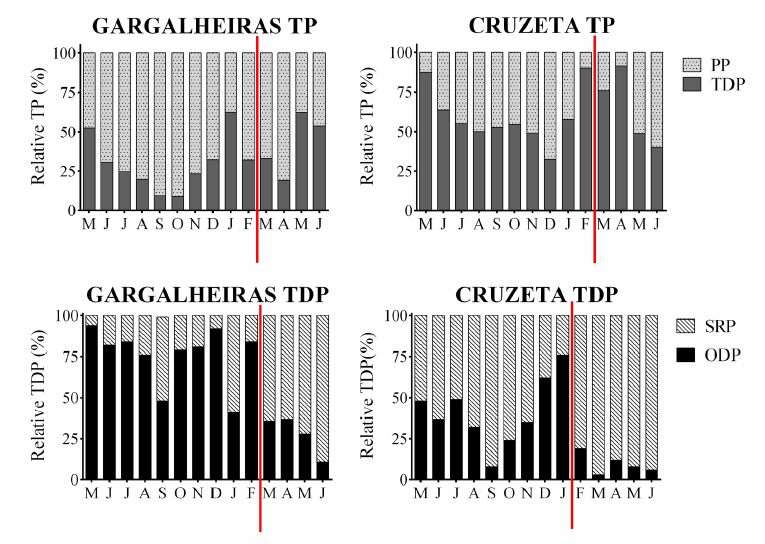
Figure 7. Relative Total phosphorus (TP) for Gargalheiras and Cruzeta, composed of the fractions of Particulate Phosphorus (PP) and Total Dissolved Phosphorus (TDP); and Relative Total Dissolved Phosphorus (TDP), composed of the fractions of Soluble Reactive Phosphorus (SRP) and Organic Dissolved phosphorus (ODP). The red line is indicating the highest rainfall in the period, which contributed to the increase in water depth, as can be seen in the figure.